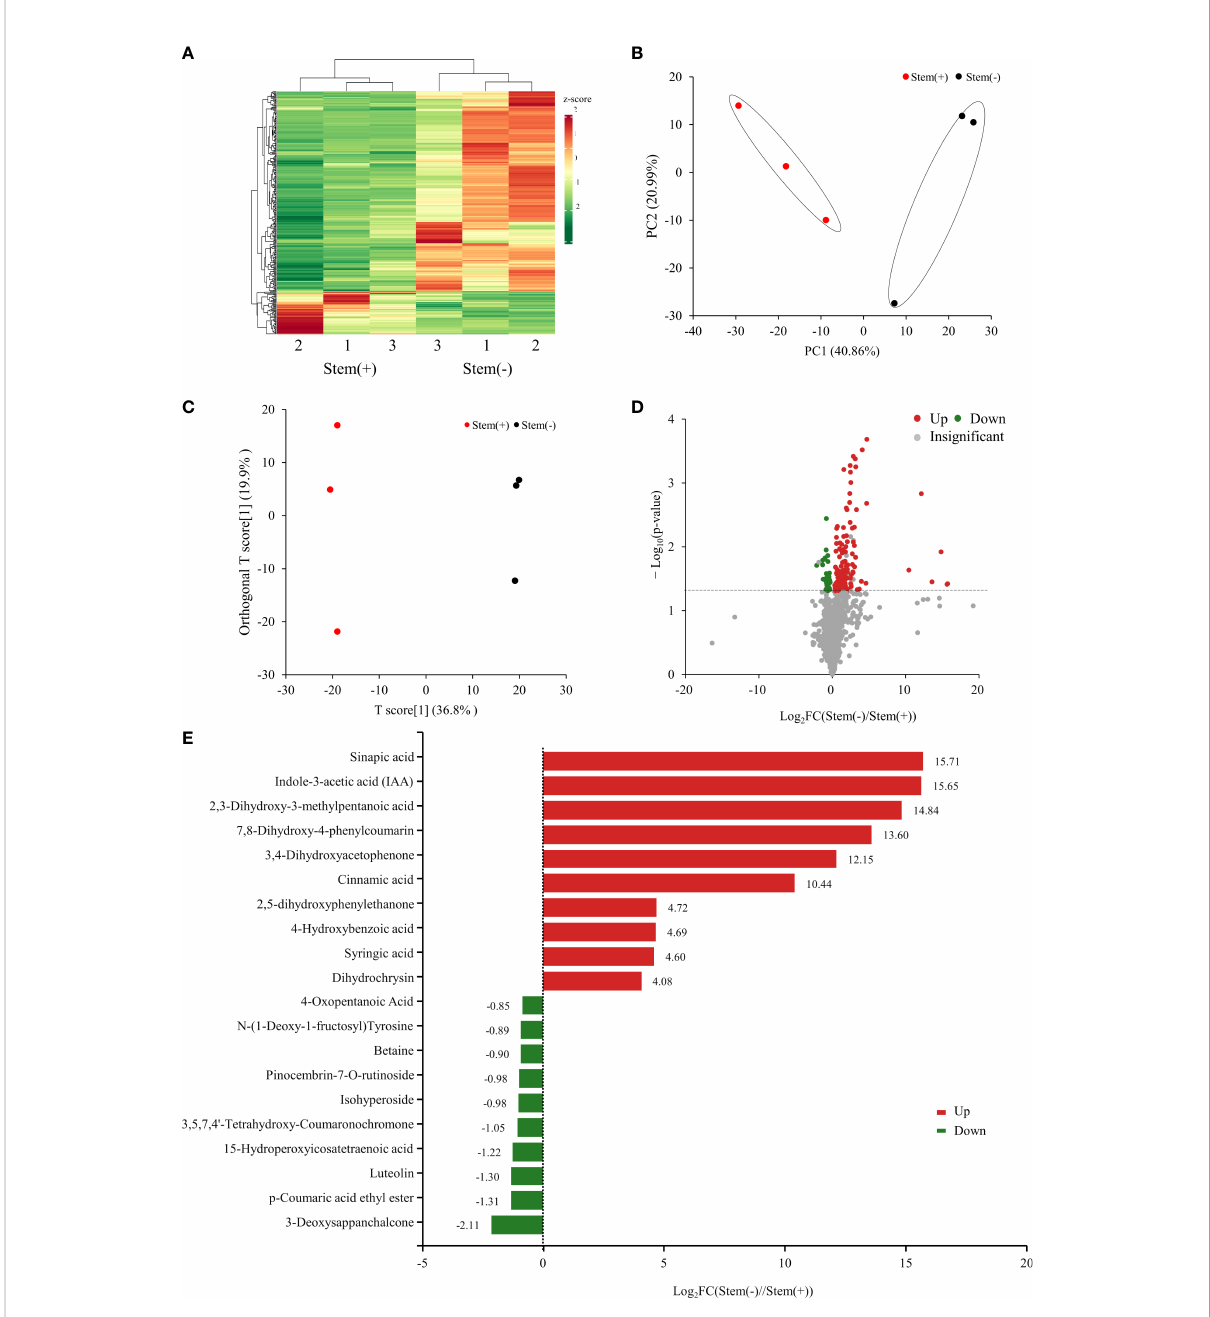
FIGURE 2 Metabolome analysis of tobacco leaves. (A) Heatmap of relative metabolites concentrations. The clustered dendrogram of samples was on the top. (B) PCA score plot of metabolite pro fi les. (C) Score scatter plots of the OPLS-DA model for stem(+) versus stem(-). (D) Volcano plot of differential metabolites between stem(+) and stem(-). (E) Top 20 differential metabolites between stem(+) and stem(-). FC, fold